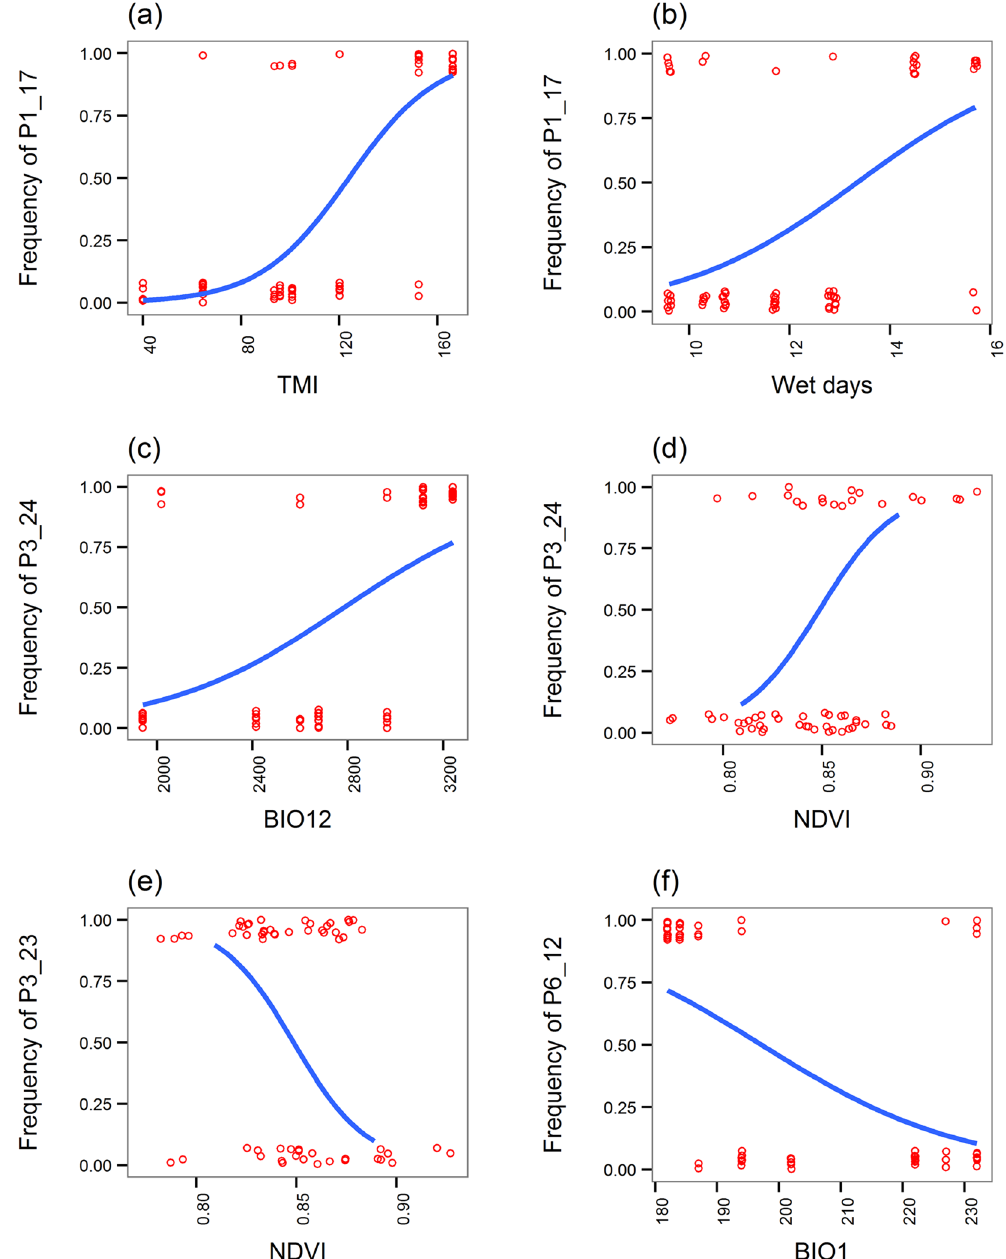
Figure 5. Logistic regression plots of four AFLP loci (P1_17, P3_23 P3_24, and P6_12) potentially evolved under selection against values of specific environmental variables. Logistic regression depicts significant positive relationships of locus P1_17 with environmental variables TMI ( a ) and wet days ( b ) (pseudo- R 2 = 0.251, P < 0.0001; pseudo- R 2 = 0.106, P = 0.0025, respectively) and of locus P3_24 with environmental variables BIO12 ( c ) and NDVI ( d ) (pseudo- R 2 = 0.094, P = 0.00897; pseudo- R 2 = 0.105, P = 0.00897, respectively), and significant negative relationship of locus P3_23 with environmental variable NDVI ( e ) (pseudo- R 2 = 0.115, P = 0.0056) and of locus P6_12 with environmental variable BIO1 ( f ) (pseudo- R 2 = 0.101, P = 0.00368). BIO1, annual mean temperature; BIO12, annual precipitation, NDVI, normalized difference vegetation index; TMI, Thornthwaite moisture index; wet days, number of days with > 0.1 mm of rain per